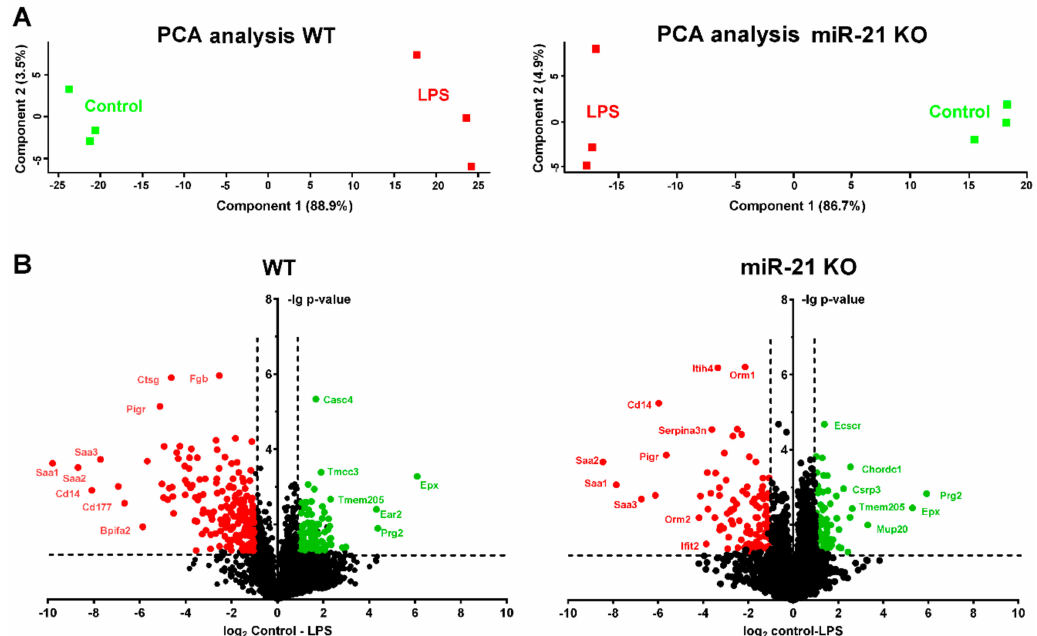
Figure 5. Proteome analyses of mice challenged with LPS. The total protein was isolated from the right lung lobes (n = 3 per experimental group) and proteome analyses were performed as described in the methods section. Principal component analyses of the regulated proteins showing separated groups of the replicate analyses ( A ). The volcano plots display the up- and down-regulated proteins ( B ). X-axes give the ratios of the mean protein intensities as log 2 -values. Y-axes show the –lg of the p-values. The proteins upregulated in the LPS-treated samples are shown in red, and proteins downregulated in the LPS samples are shown in green. Some selected proteins are indicated by the gene